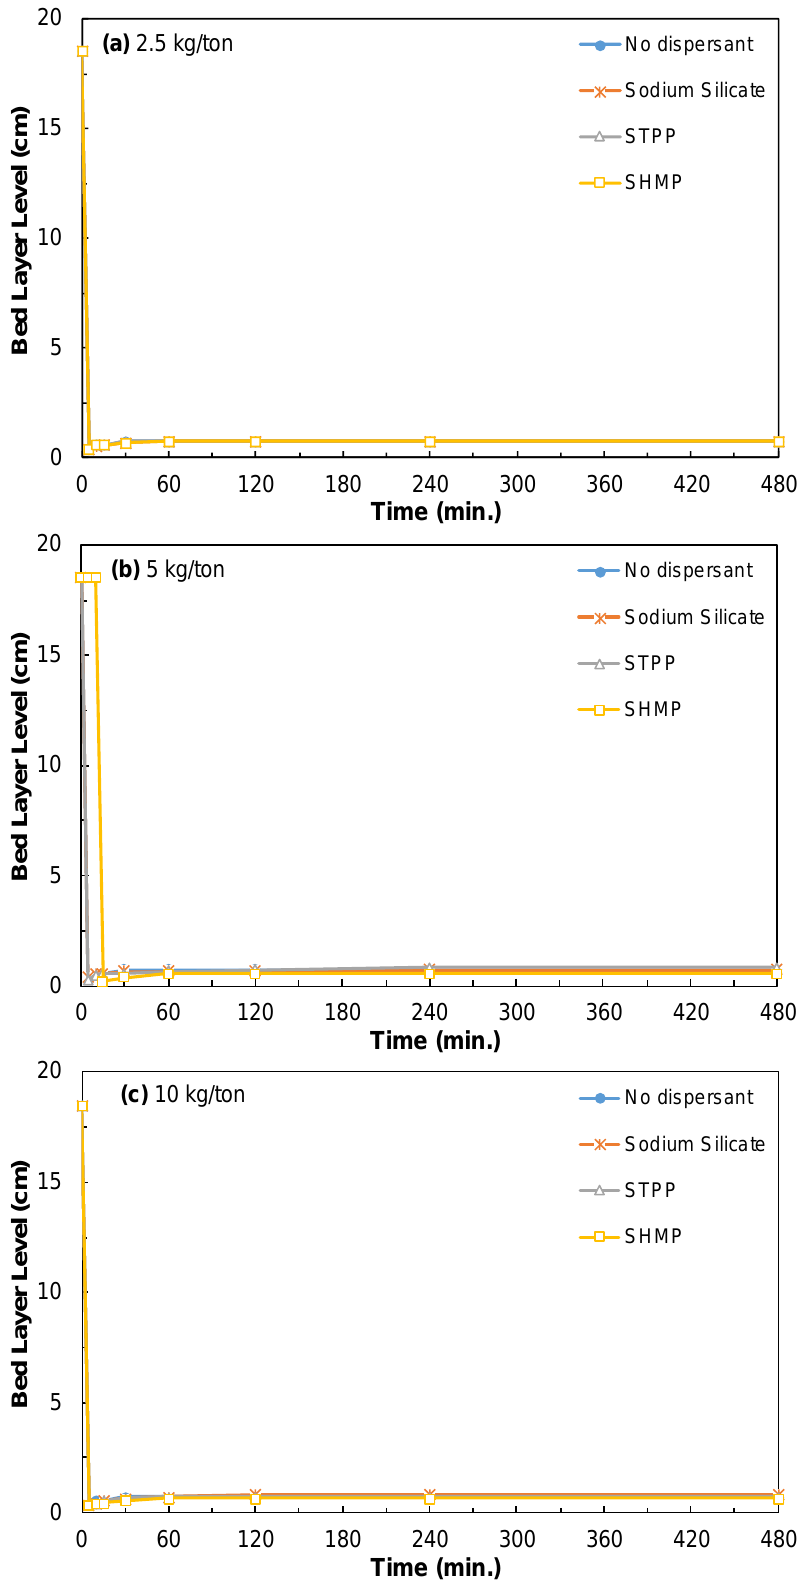
Figure 11. Quartz sedimentation behavior in the presence of dispersants at concentrations of ( a ) 2.5 kg/ton, ( b ) 5 kg/ton, and ( c ) 10 kg/ton at natural pH and room